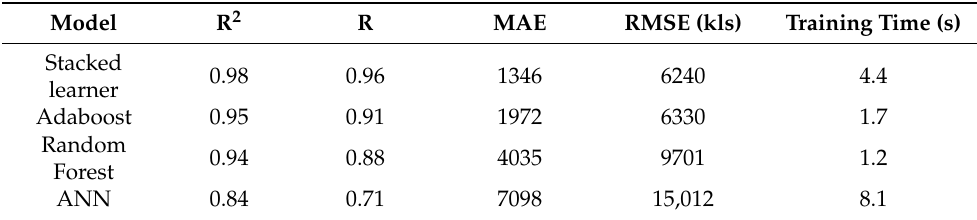
Figure 7. Proxy results charts for incremental oil (kls) where ( a ) Stacked learner with 3000 samples; ( b ) AdaBoost with 3000 samples; ( c ) Random Forest with 3000 samples; ( d ) Stacked learner with 2000 samples; ( e ) AdaBoost with 2000 samples; ( f ) Random Forest with 2000 samples; ( g ) Stacked learner with 1000 samples; ( h ) AdaBoost with 1000 samples; ( i ) Random Forest with 1000 samples. The ordinate refer to the proxy predictions and the abscissa refer to the numerical simulation results. Table 7. Summary of proxy performance and time to make predictions for 3000 samples for various